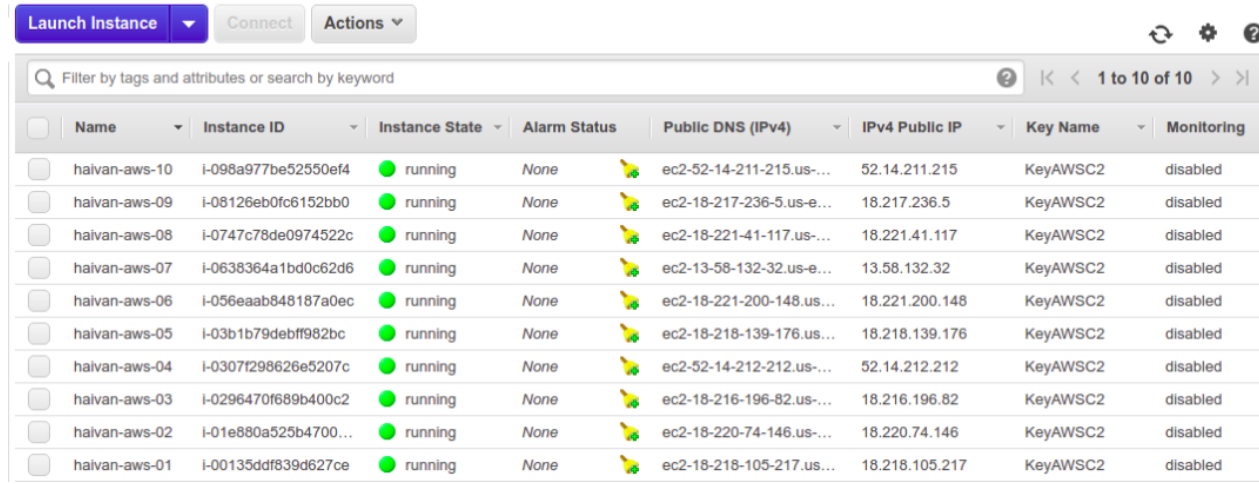
Figure 12. AWSC2 Instances